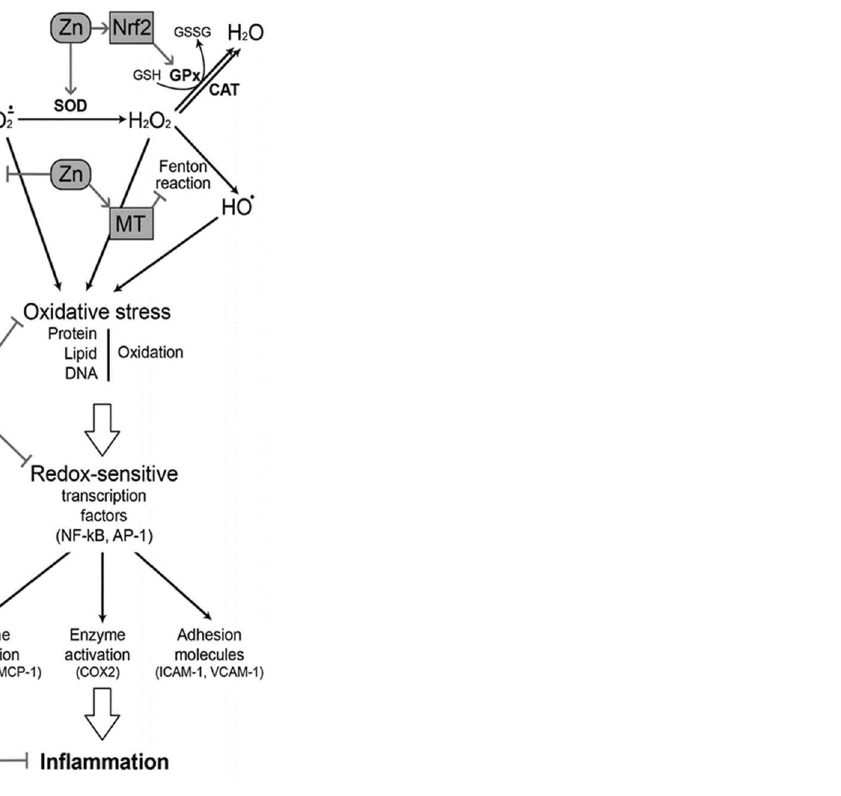
Figure 4. The various pathways in which zinc influences oxidative stress and inflammation. Adapted from [12].